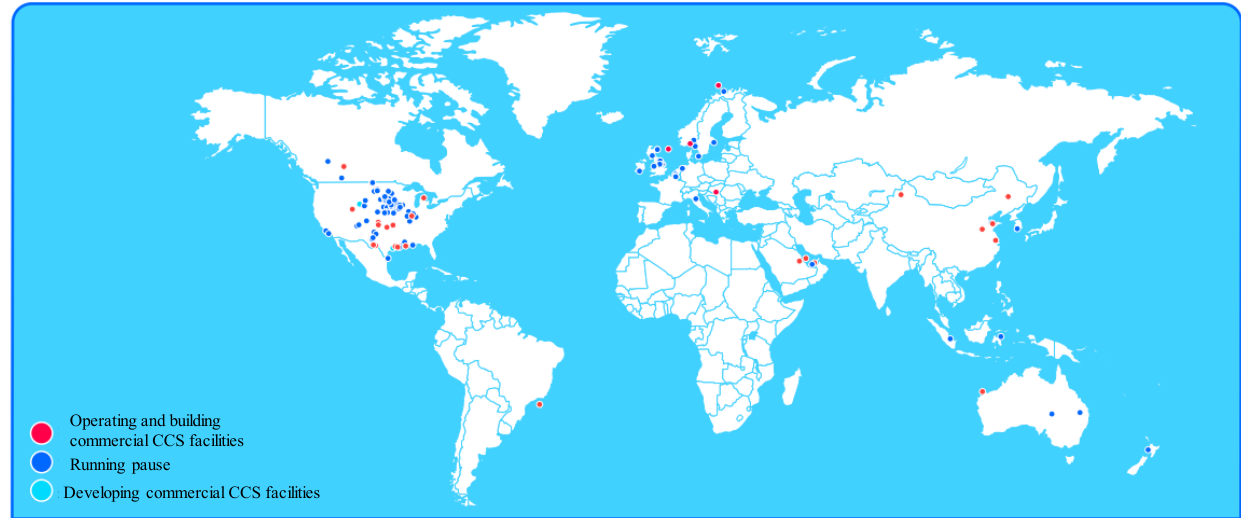
Figure 1. Global CCS Project Distribution Map [3].